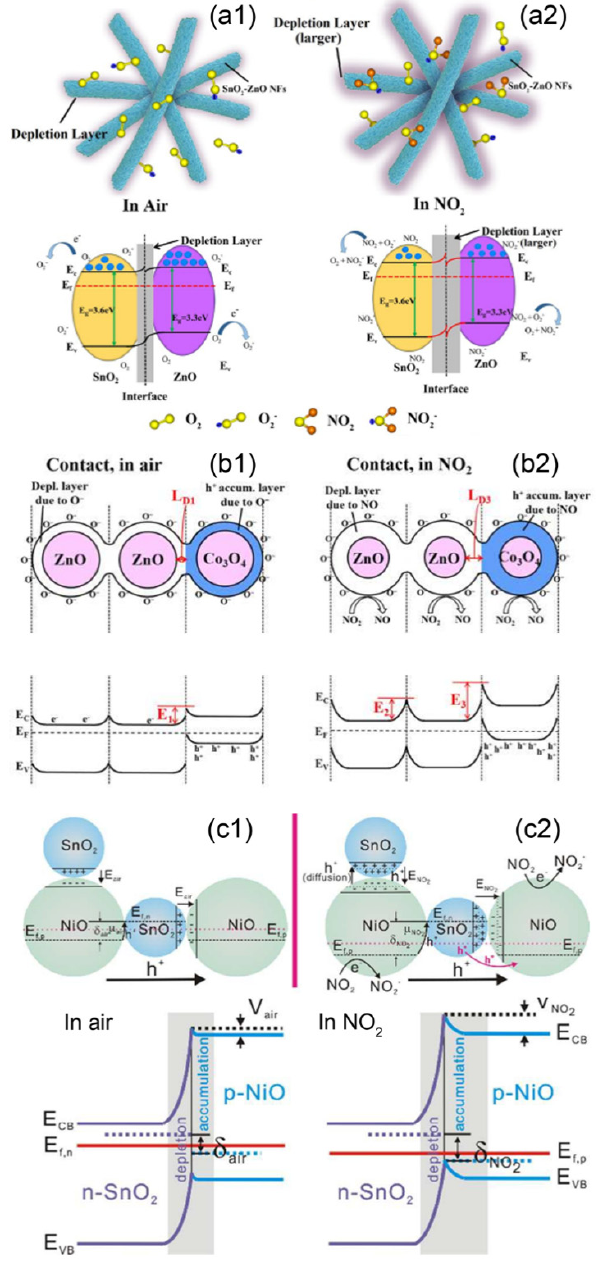
Figure 8. The enhanced gas sensing mechanisms of ( a1 , a2 ) the hollow nanofibres of ZnO-SnO 2 (n-n heterojunction) (Copied with permission [151]. Copyright 2018, Elsevier.), ( b1 , b2 ) the ZnO/Co 3 O 4 composite nanoparticle (n-p heterojunction) (Copied with permission [64]. Copyright 2016, Elsevier.) and ( c1 , c2 ) NiO-SnO 2 nanocomposites (p-n heterojunction) (Copied with permission [154]. Copyright 2016, Royal Society of Chemistry.) towards oxidising gases.